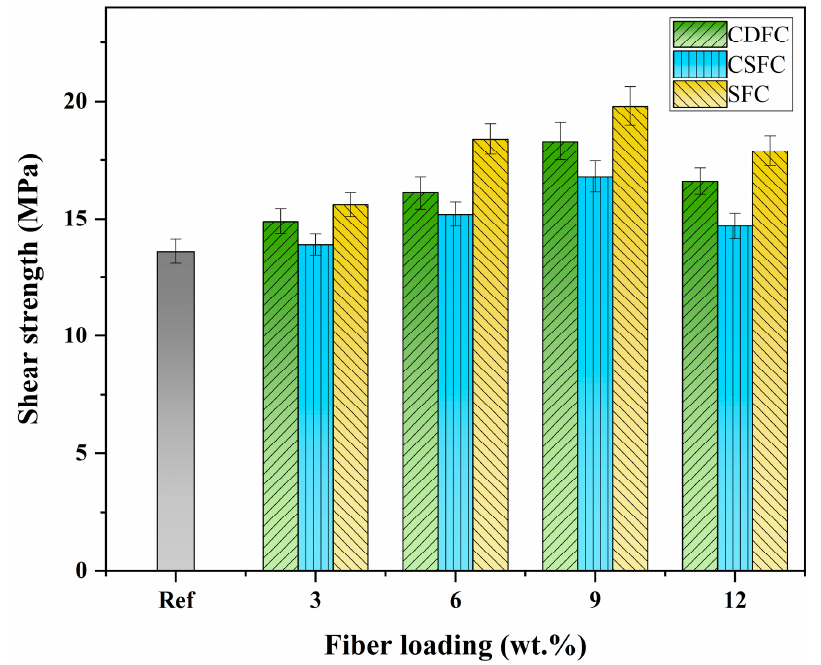
Figure 8. Shear strength of the polymer composites CDFC, CSFC, and SFC at different fiber loadings. A further comparison of the CDFC, CSFC, and SFC revealed that, at the same fiber addition level, the CDFC exhibited better shear strength compared to the CSFC but was poorer to varying degrees than the SFC. This observation was similar to the comparative results of the impact strength. In fact, as reported, the strength of the composite systems depended not only on the fiber–matrix interfacial bonding but also on the strength of the fibers [27]. The behavior of the cow dung fiber composites (CDFC) with a moderate level of shear strength can also be explained by the reasons mentioned in Section